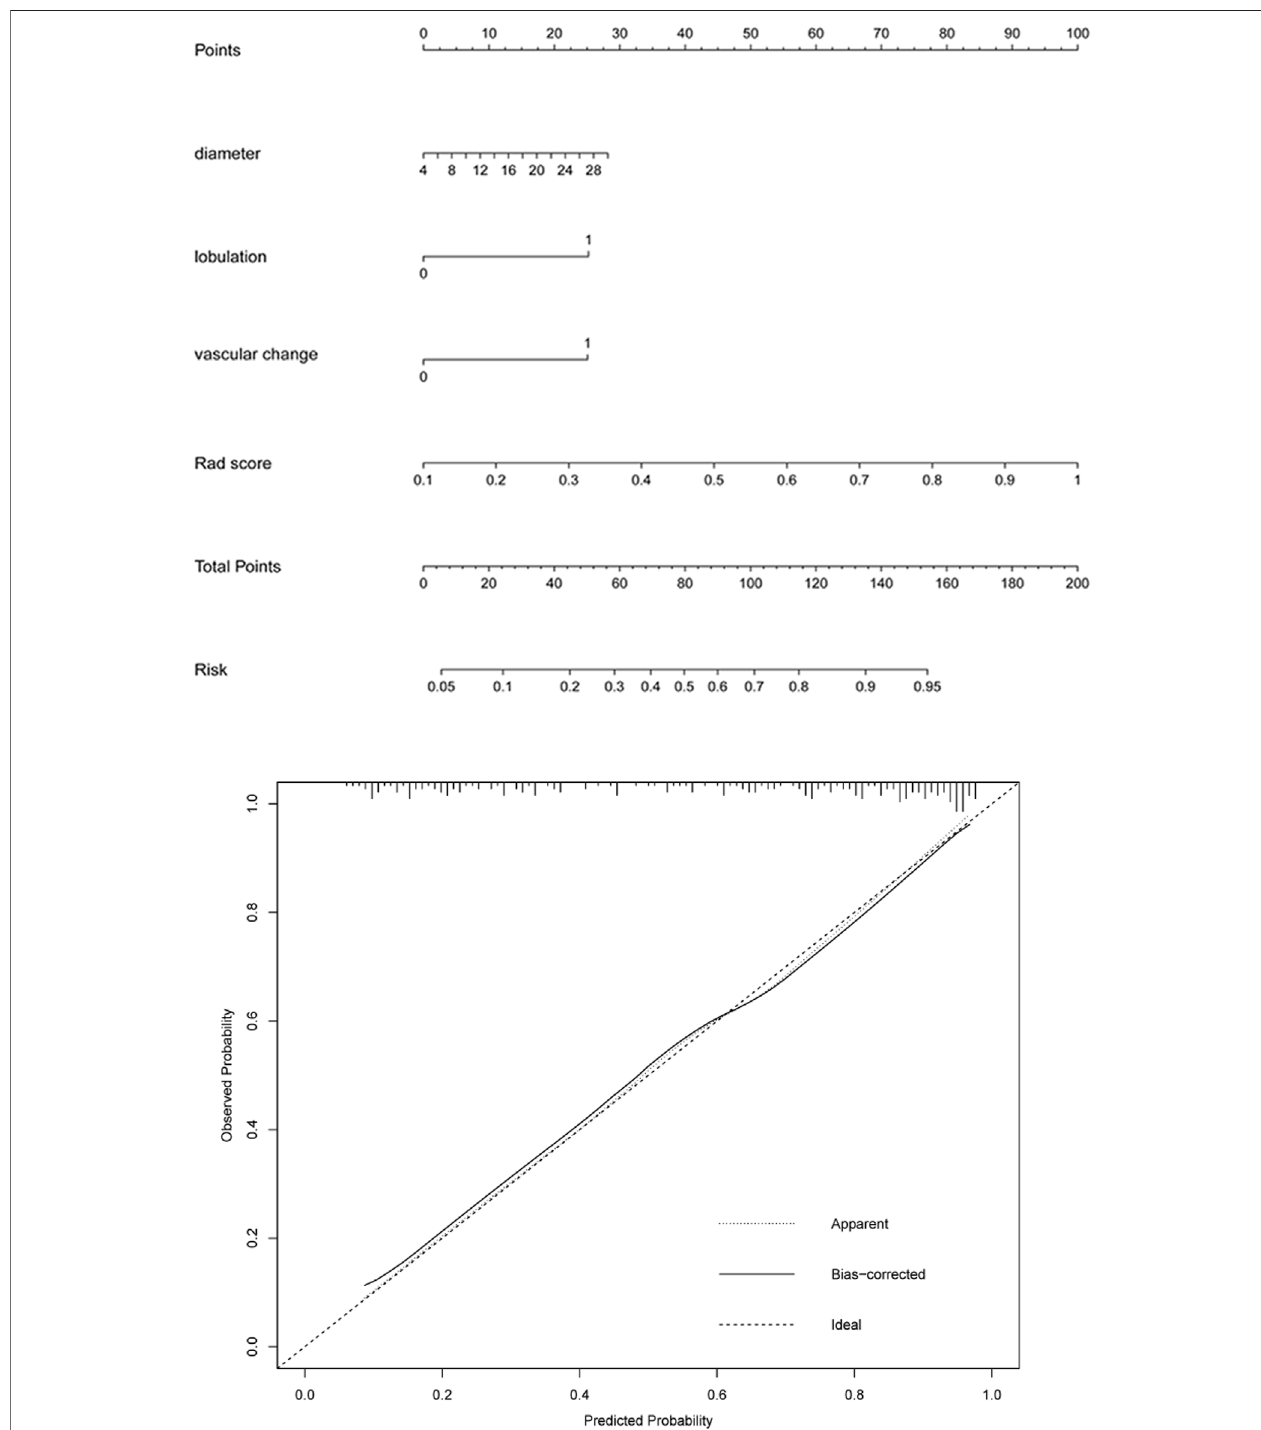
FIGURE4| Aradiomics-basednomogramwasdevelopedinthetrainingset.Theradiomics-basednomogramwasdevelopedinthetrainingset,andthediameter, lobulation, vascular change, and Rad score were incorporated. The total score was calculated by adding the score for each risk factor, and then the probability of IAC was predicted on the risk